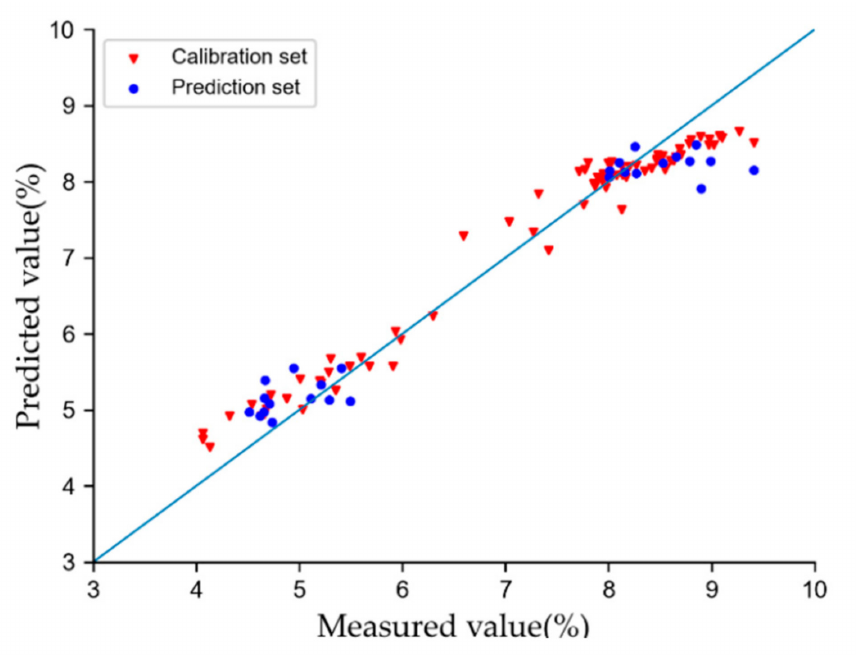
Figure 4. Prediction results of tea polyphenols after pretreatment of raw spectra by SG algorithm, and “%” indicates the percentage of tea polyphenols in the dry matter of the tea